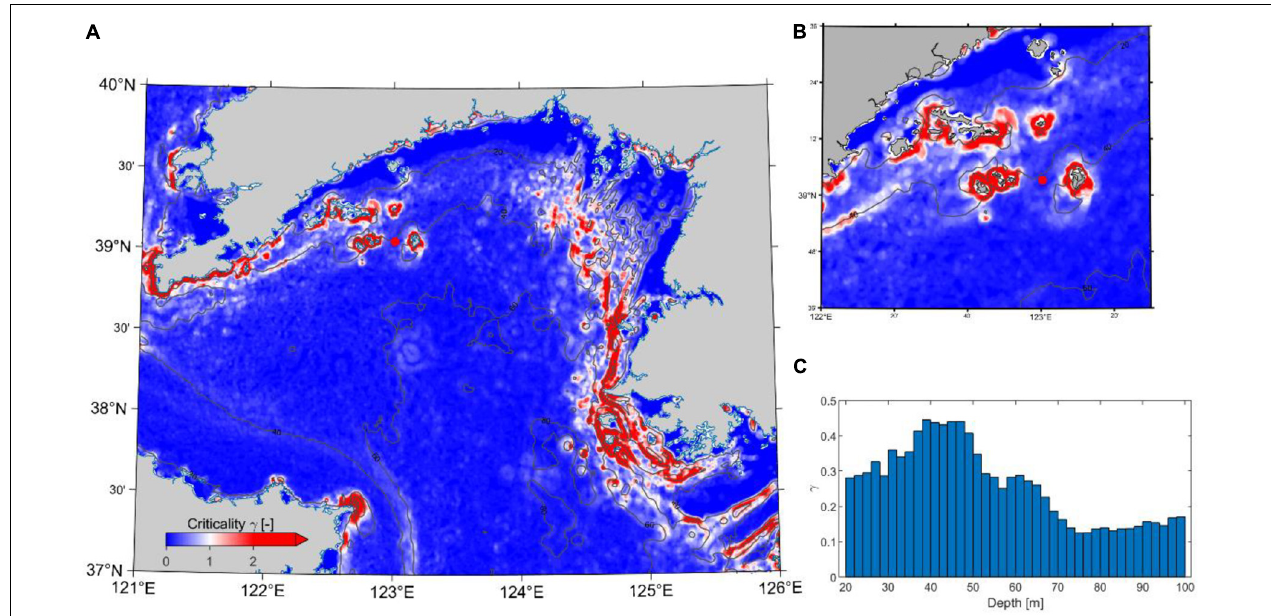
FIGURE 9 | (A) Criticality of the topography on the northern Yellow Sea shelf estimated from the mean simulated buoyancy frequency near the bottom between July 26 and August 10. Solid lines represent the isobath contours of 20, 40, 60, and 80 m. (B) Detailed view of slope criticality near the mooring ADCP (red dot). (C) The depth-mean topographic criticality calculated for the northern Yellow